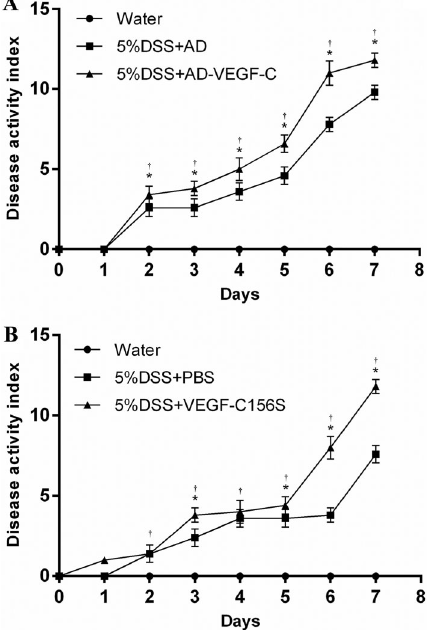
Figure 1. Evaluation of disease activity index (DAI) in AD-VEGF- C-treated mice. Mean DAI scores ( ± SD) were higher in